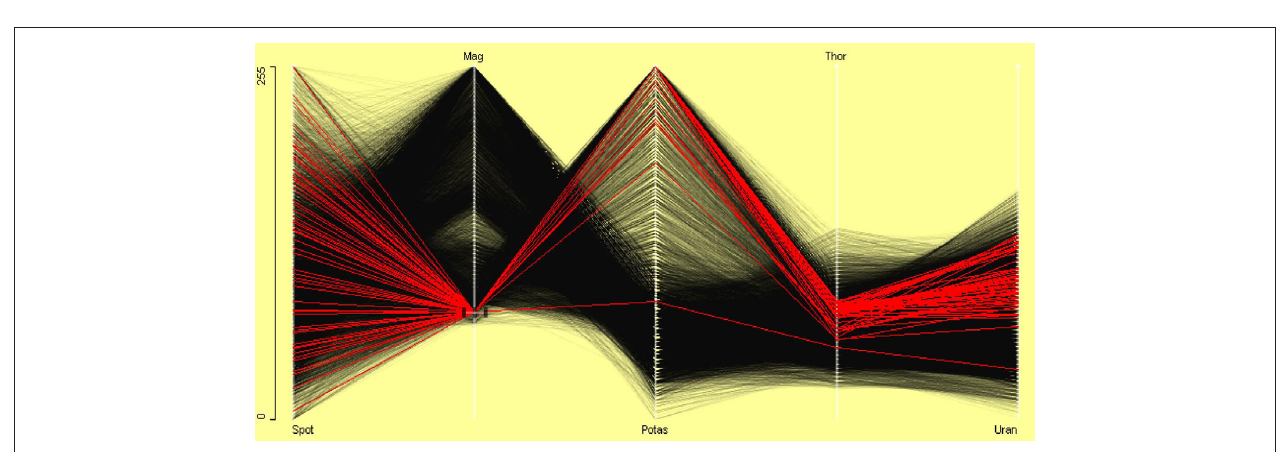
FIgurE 12 | A small group is selected in Mag variable. It shows an outlier with low potassium, thorium, and uranium values.